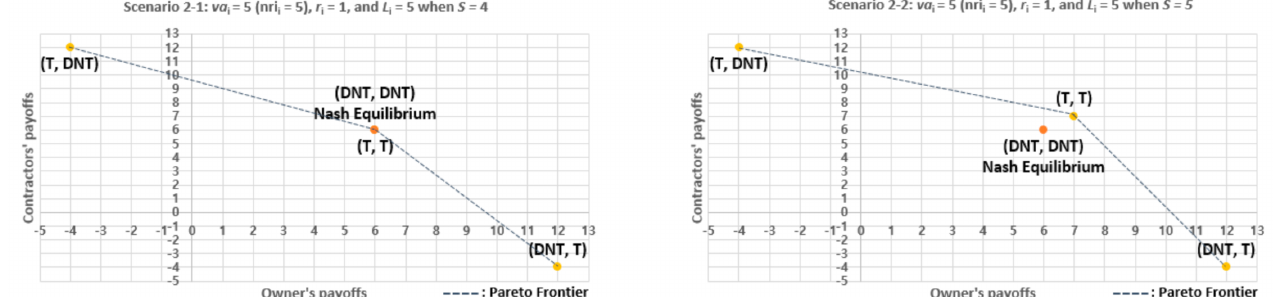
Figure 2. Nash equilibrium and Pareto frontier in Scenario